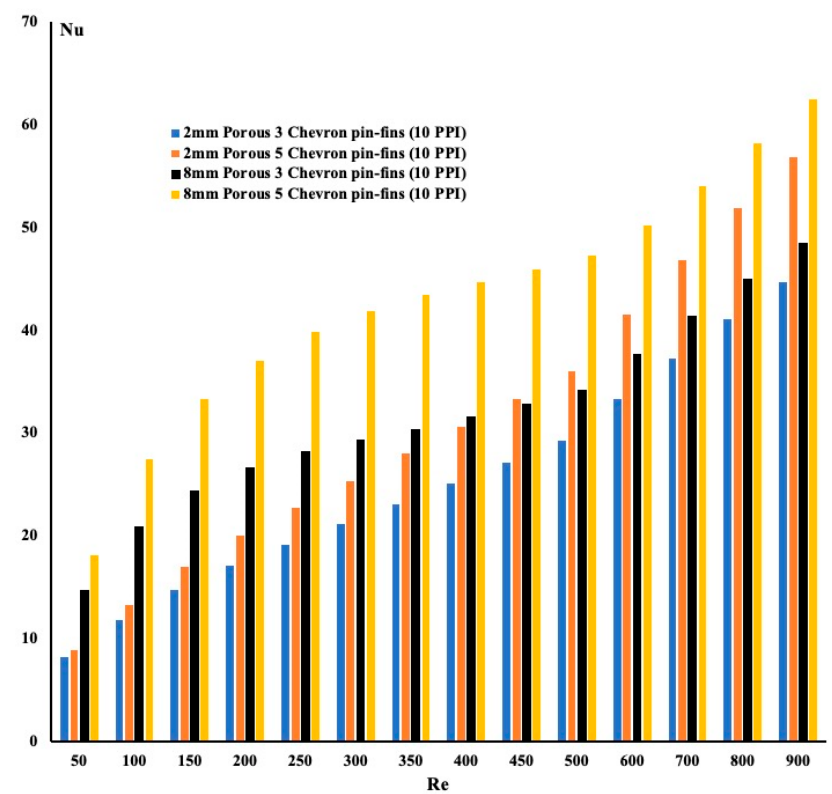
Figure 7. Average Nusselt number for porous pin-fins with a permeability of 10 PPI.